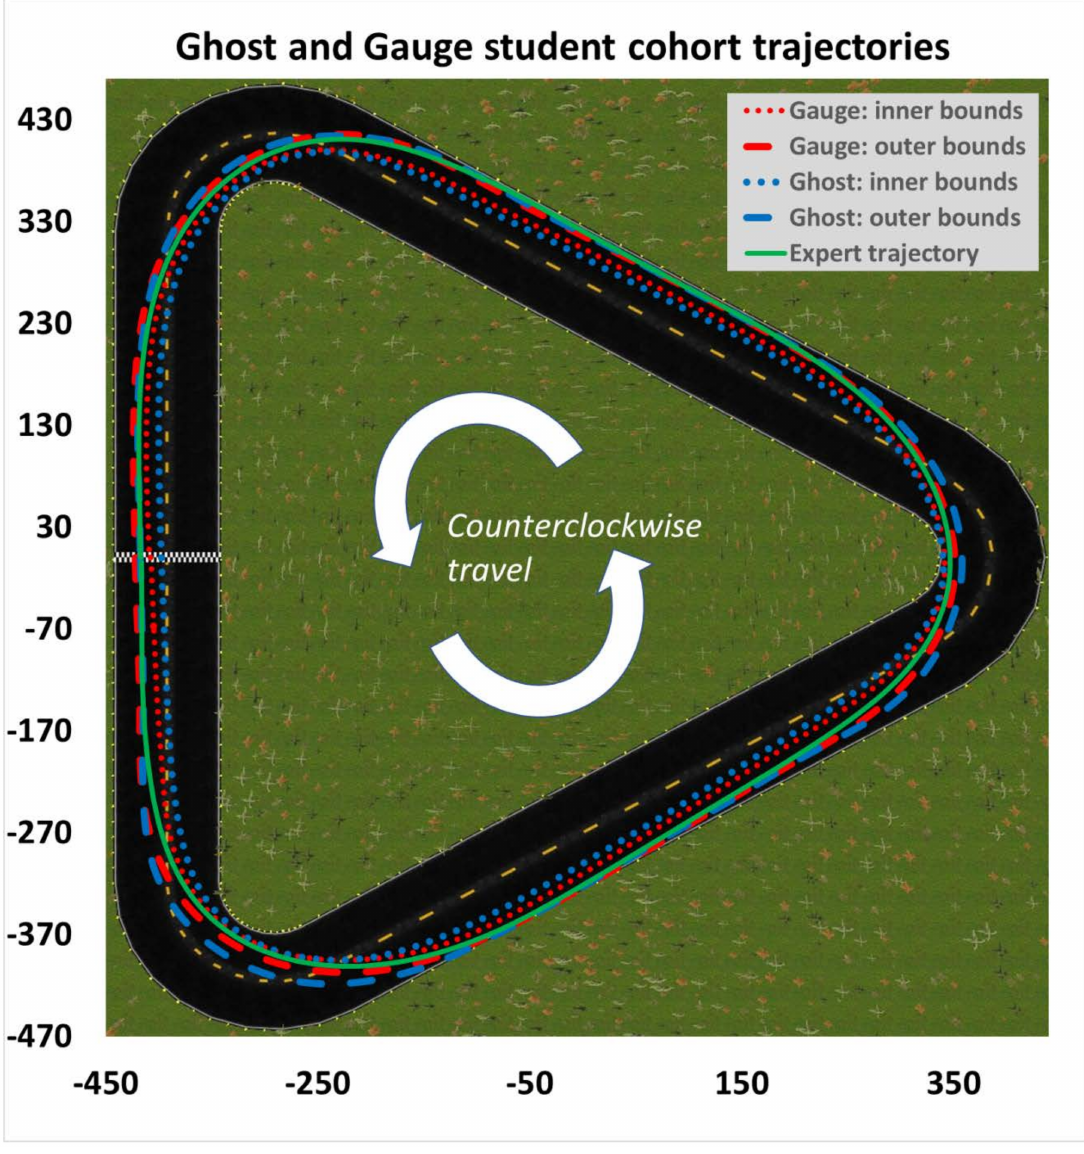
Figure 17. Ghost trainer vs. gauge trainer race trajectories (with upper/lower